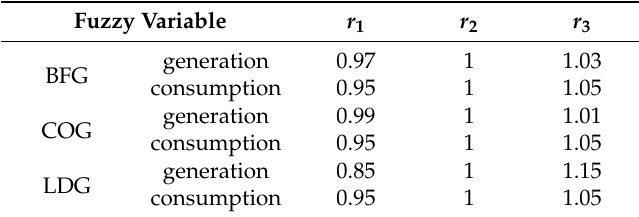
Table 5. Triangle fuzzy scaling factors of gas generation and